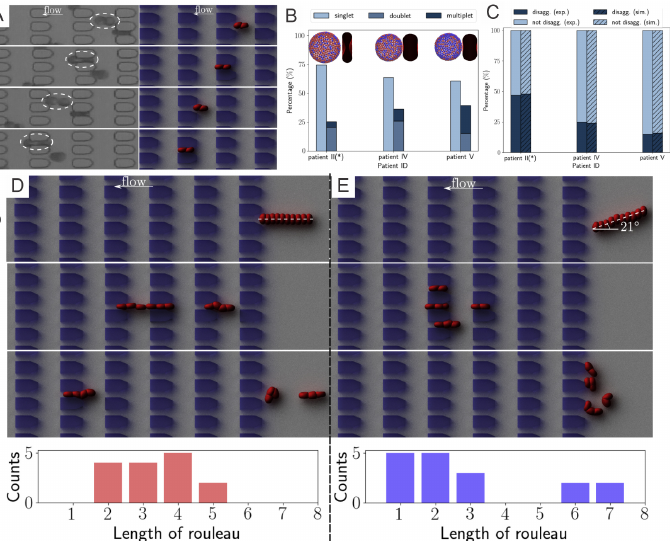
Figure 3. ( A ) Experimental results of a T2DM doublet squeezing through microgates in experiment (left column) and companion simulation (right column). ( B ) Comparison on the percentage of rouleaux with different lengths detected from three different patients ( ∗ signifies that patients of obesity, not diabetes). ( C ) Doublet disaggregation rate measured from simulation and experiments; exp., experiment; sim., simulation. Different rouleaux breakup patterns of two 10-cell rouleaux of the rouleaux flow in ( D ) parallel to and ( E ) with a 21 ◦ inclination angle to the flow direction ( t 0 = 0 s, t 1 ≈ 3 s, t 2 ≈ 4.5 s). Bottom histograms show the accumulated results of five different runs. Figures are adopted from [71] with